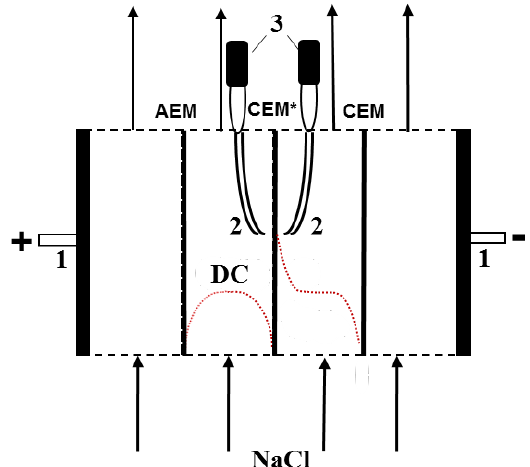
Figure 1. Schematic diagram of the electrochemical cell for measuring the current–voltage characteristics and pH at the inlet and outlet of the DC formed by the cation-exchange membrane under study (CEM*) and an auxiliary anion-exchange membrane: 1—polarizing platinum electrodes; 2—Luggin capillaries connected to the microreservoir in which Ag / AgCl electrodes are immersed (3). The dashed lines show the concentration profiles of the electrolyte in the cell channels separated by the membrane under study.